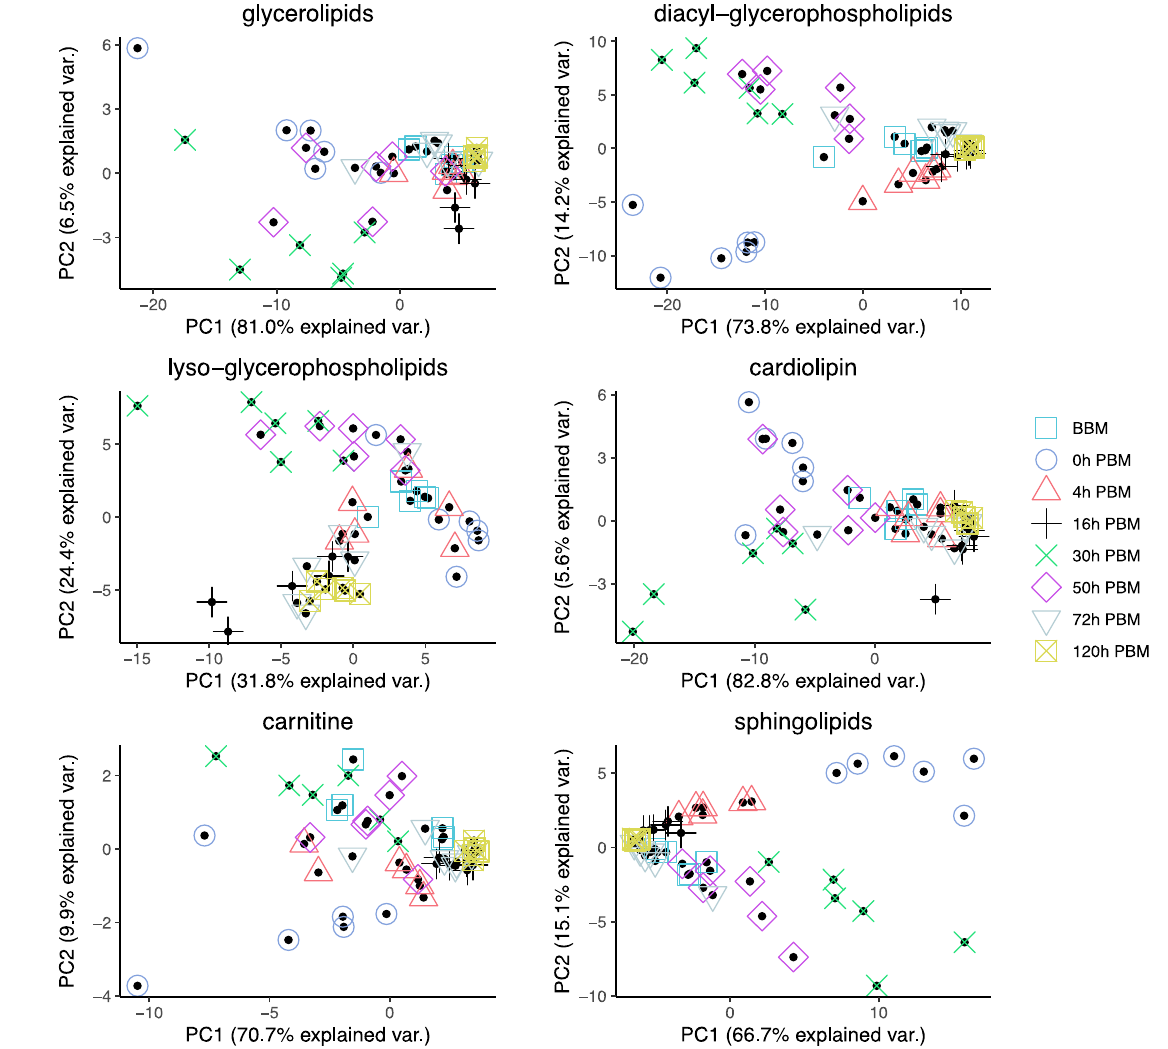
Figure 4. Principal Component Analysis of different groups of lipids in Aedes aegypti females at dif- ferent time points over the course of feeding and reproduction. Color and shape symbols correspond to the eight time points before blood meal (BBM) and post blood meal (PBM).